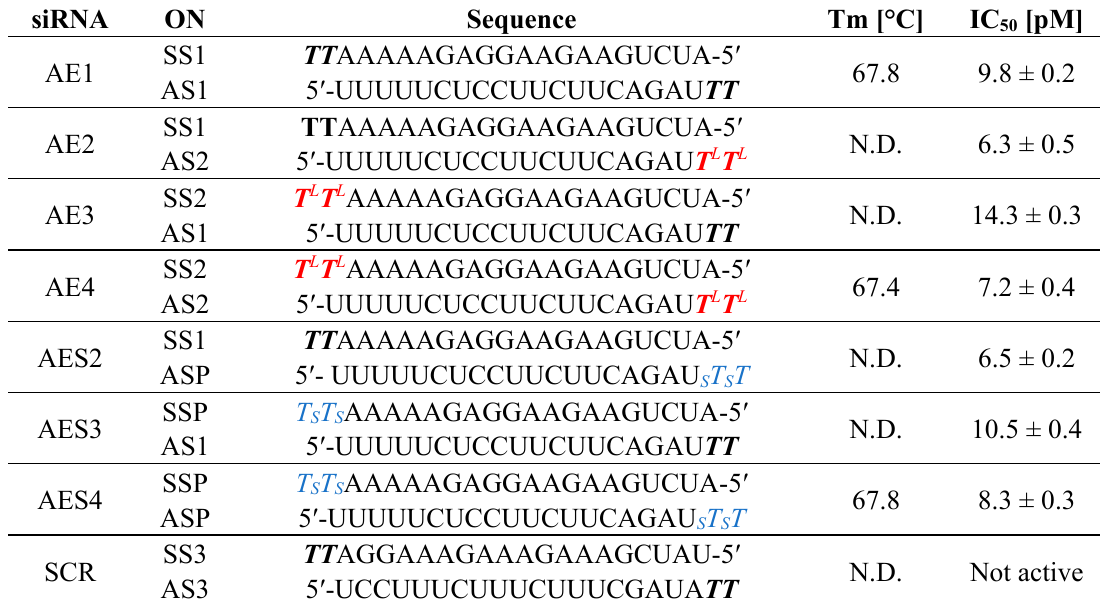
Table 2. Sequences of unmodified and modified siRNAs targeting the Renilla luciferase mRNA and scrambled (SCR) siRNA; Tm (±0.5 °C) and Median Inhibition Concentration (IC 50 ) values (mean ± SD). T L : L-threoninol-thymine monomer; T S : thymidine